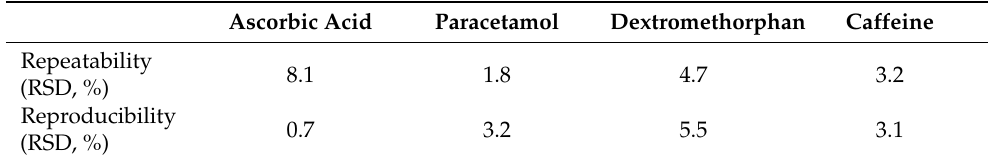
Table 2. Repeatability and reproducibility values for the simultaneous determination of ascorbic acid, paracetamol, dextromethorphan and caffeine by differential pulse voltammetry using a SPCE in 0.1 mol L − 1 acetic/acetate buffer pH